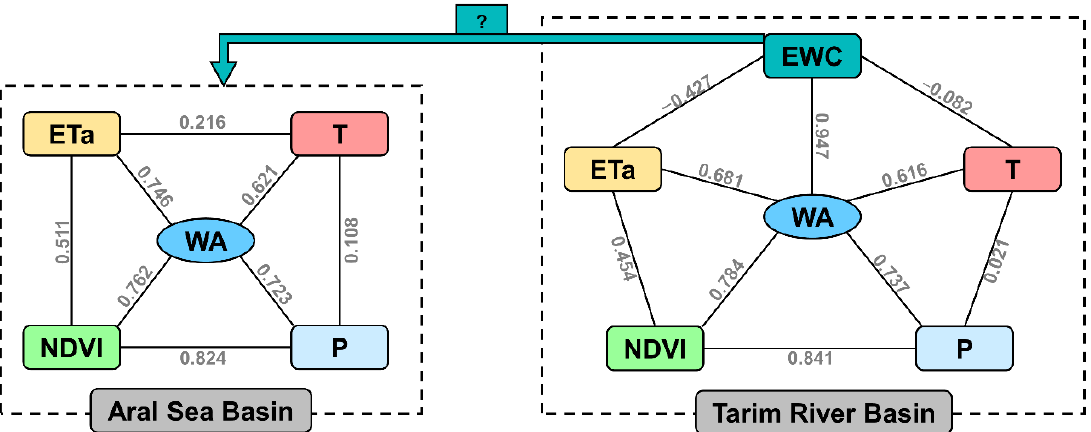
Figure 6. Relationships between the main factors driving changes in water area (WA) in the Aral Sea Basin and the Tarim River Basin, Central Asia. ETa represents the actual evapotranspiration; T represents the temperature; P represents the precipitation; NDVI represents the normalized difference vegetation index; EWC represents the ecological water conveyance. “?” represents whether the EWC project in the Tarim River Basin can be applied to the Aral Sea basin. The grey numbers on each line indicate the correlation (Pearson correlation coefficient) between the factors at either end of the line [84]. The closer this value converges to 1, the more likely it is that the two are significantly positively